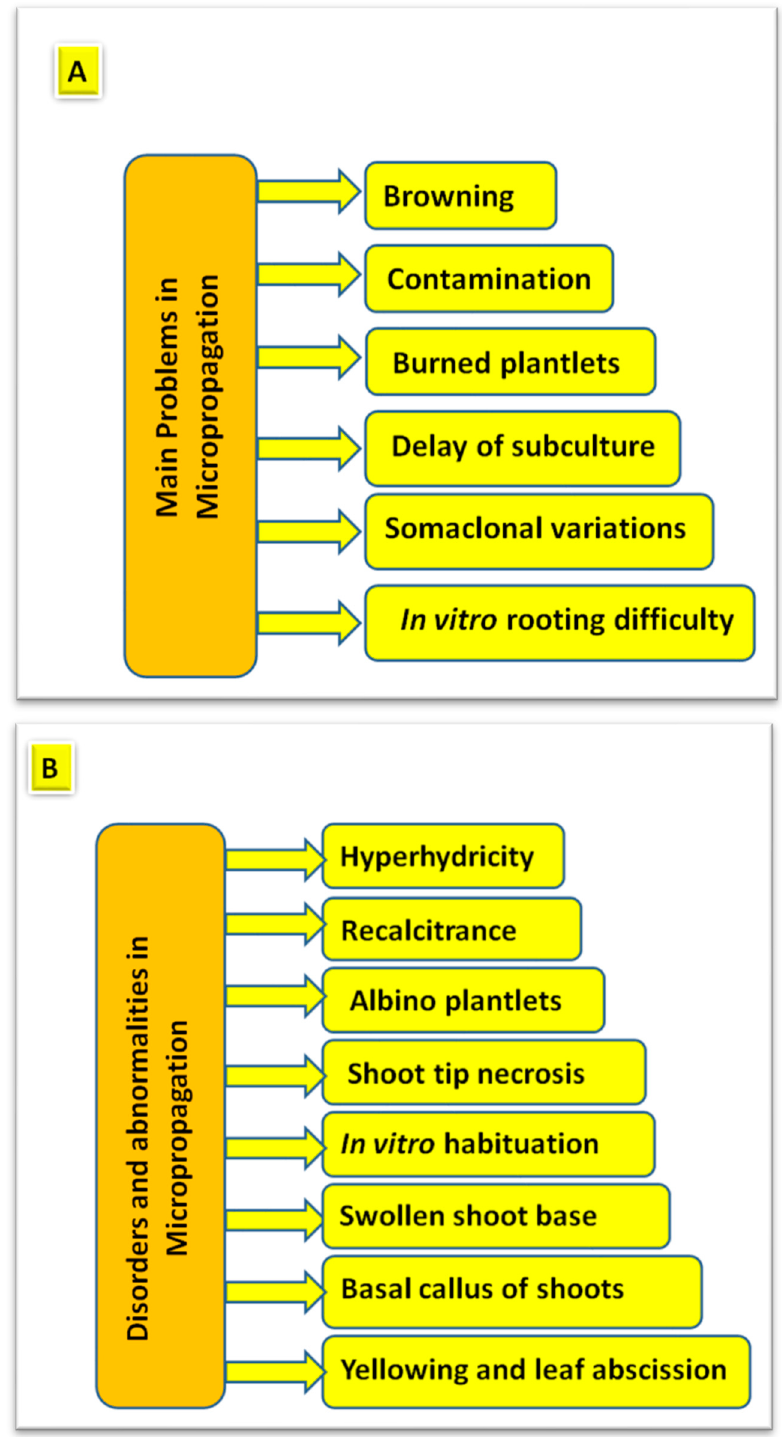
Figure 11. A chart showing the main problems in the field of plant micropropagation ( A ) and different disorders and abnormalities ( B ) in this field.